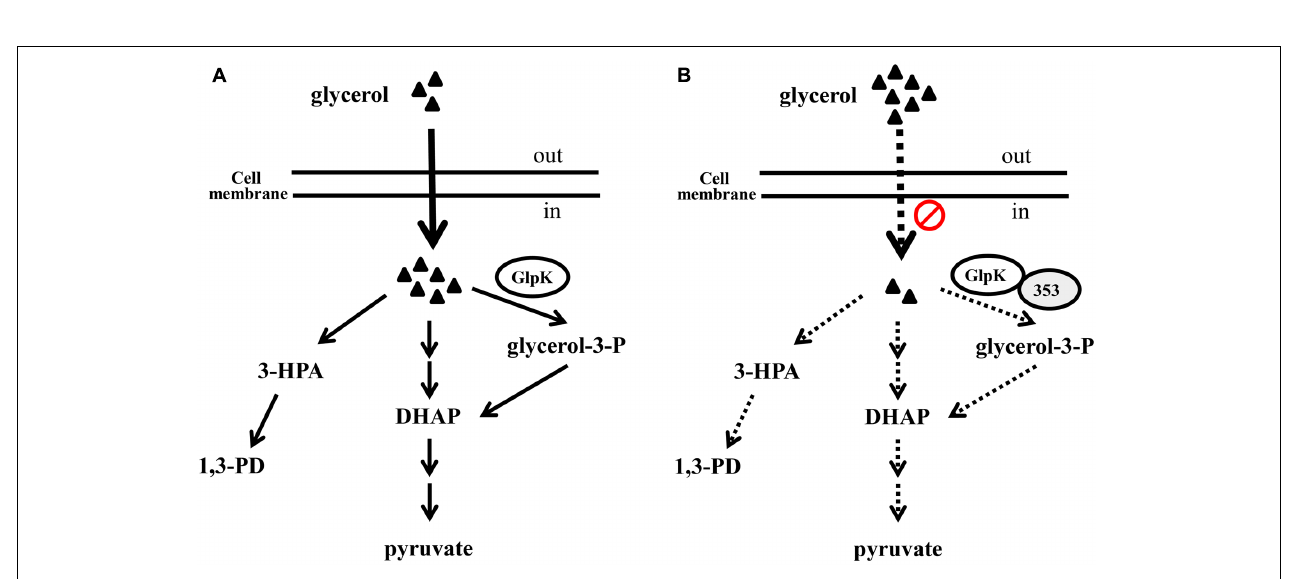
FIGURE 10 | The hypothetical role of KPN00353 in glycerol metabolism in K. pneumoniae . Glycerol is metabolized by respiratory metabolism which GlpK is involved in and oxidative fermentation to produced DHAP or by reductive pathway to produce 1,3-PD under (micro)aerobic condition (A) . We hypothesize that the interaction of GlpK and KPN00353 (353) decreases the glycerol uptake into bacterium (in B ). The reduction of intracellular glycerol results in the low activity of glycerol metabolism. Dash lines in (B) indicate the activities of reactions or pathways in (B) are lower than those represented by solid lines in (A) . Triangle indicates glycerol.